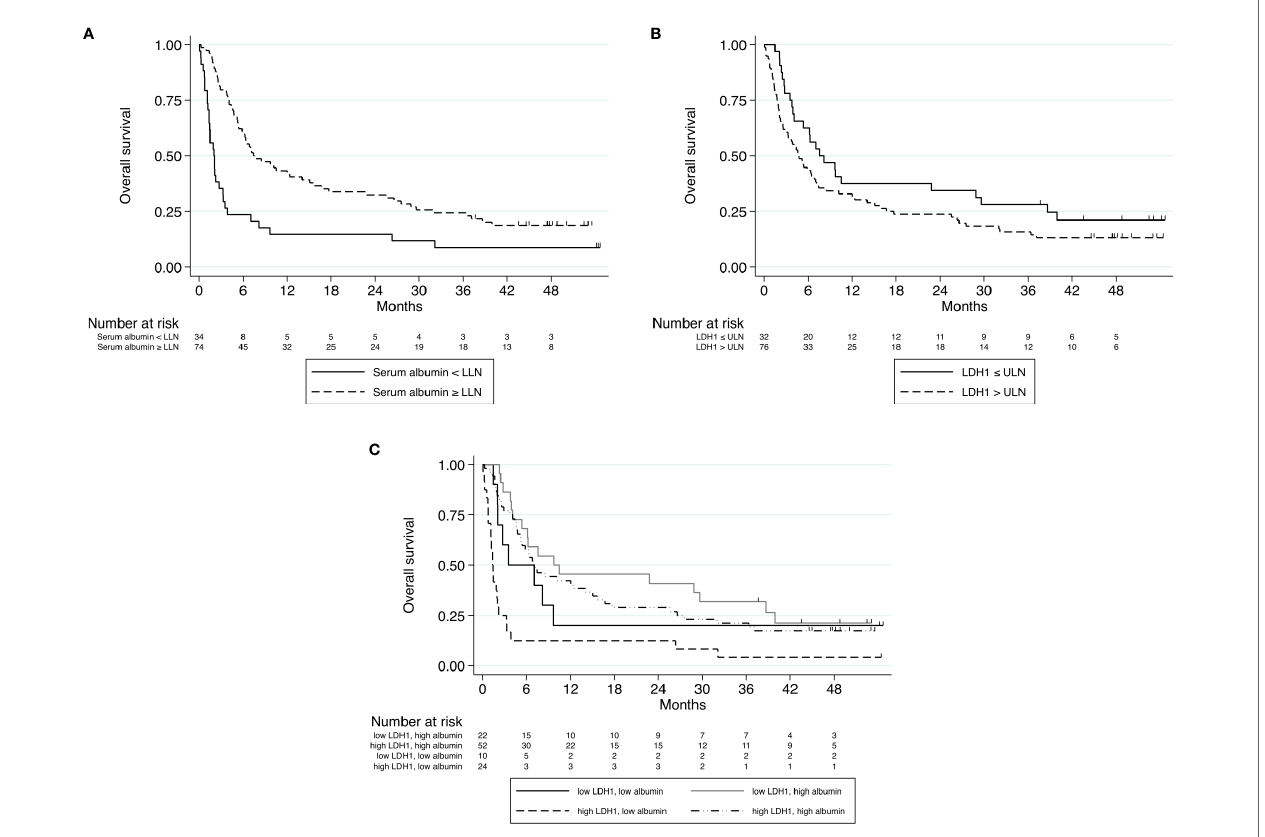
FIGURE 3 | (A) Kaplan – Meier curve for overall survival strati fi ed according to Albumin level at baseline (normal or below the lower limit of normal, n=108). (B) Kaplan – Meier curve for overall survival strati fi ed according to LDH level at baseline (above upper limit of normal\below upper limit of normal, n=108). (C) Kaplan – Meier curves for overall survival strati fi ed according to combined Albumin and LDH levels at baseline. (A) HR 0.33, 95% CI (0.20 - 0.52), p<0.001 (B) HR 1.15, 95% CI (1.06 - 1.25), p=0.001 (C)